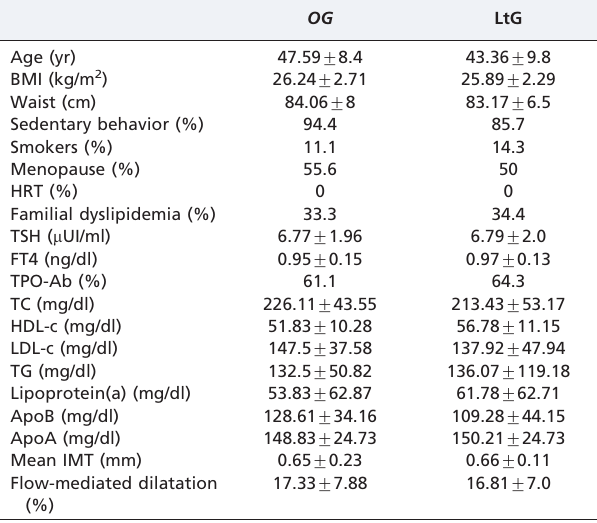
Table 1 - Baseline data of levothyroxine-treated and observation groups.